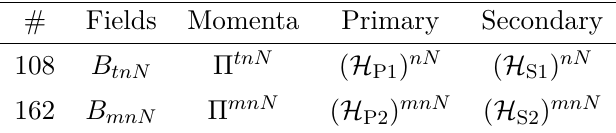
Table 2 . This table lists the number and names of the independent components of all the fields, canonical momenta as well as of the primary and secondary constraints. transformation δ B as in equation mnN H P2 [ λ ]